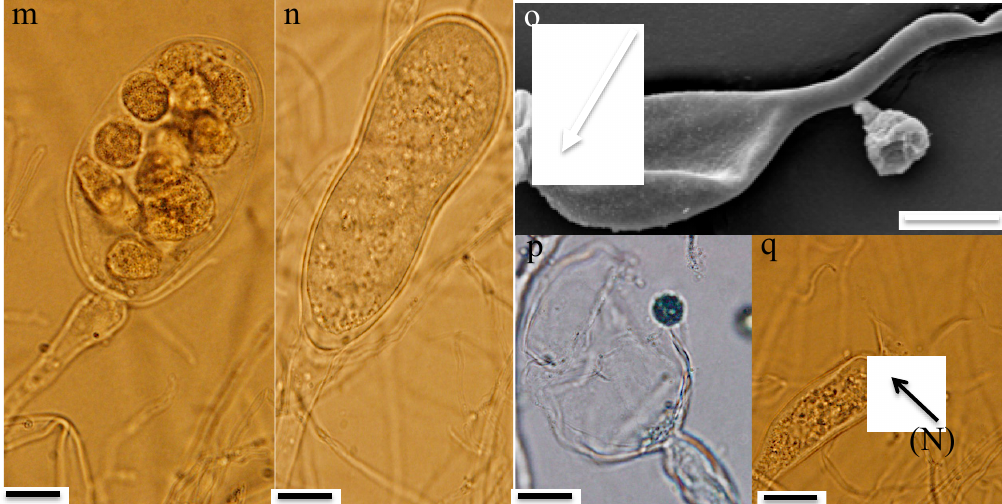
Figure 2. Microscopic features of Aestipascuomyces dupliciliberans type strain R4. Light ( a – h , k – n, and p – q ), fluorescence ( c and e ) and scanning electron ( i , j , and o ) micrographs are shown. ( b , c ) and ( d , e ) each depict the same field with ( c ) and ( e ) showing the fluorescence field, and ( b ) and ( d ) showing the overlay of fluorescence and phase contrast micrographs. ( a ) A spherical polyflagellated zoospore. ( b – e ) Monocentric thalli; nuclei were observed in sporangia, not in rhizoids or sporangiophore. ( f – h ) Endogenous sporangia: ( f ) ovoid sporangium with single rhizoidal system, ( g ) rhomboid sporangium with two adjacent rhizoidal systems, and ( h ) elongated sporangium. ( i – n ) Exogenous sporangia: ( i ) obpyriform sporangium on a flattened sporangiophore, ( j ) ellipsoidal sporangium on a long sporangiophore, (k) globose sporangium with sub-sporangial swelling and tightly-constricted neck, ( l ) ovoid sporangium with broad neck and wide port, ( m ) mature ovoid sporangium full of zoospores, and ( n ) constricted ellipsoidal sporangium. ( o – q ) Zoospore release mechanisms: ( o ) an empty sporangium with intact wall after zoospore release through an apical pore (arrow), ( p ) zoospore release through rupturing the sporangial wall, and ( q ) collapse and disintegration of the sporangial wall after zoospore release. (SW), sub-sporangial swelling; (N), neck. Bar = 20 μ m ( a , f – h , k – n , and p – q ). Bar = 50 μ m ( b – e , i , and o ). Bar = 100 μ m ( j ).